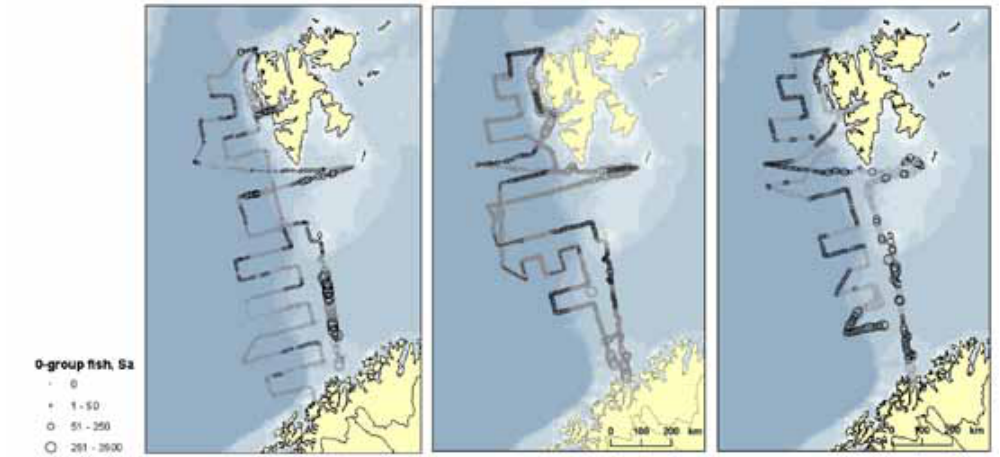
Fig. 4. Distribution of 0-group fish along the cruise lines in 2000, 2001 and 2002. Black cruise line segments indicate segments with observer effort >0 which are included in the statistical analyses of cetacean habitat and prey selection, grey cruise line segments indicate segments with observer effort=0 which are not included in the statistical